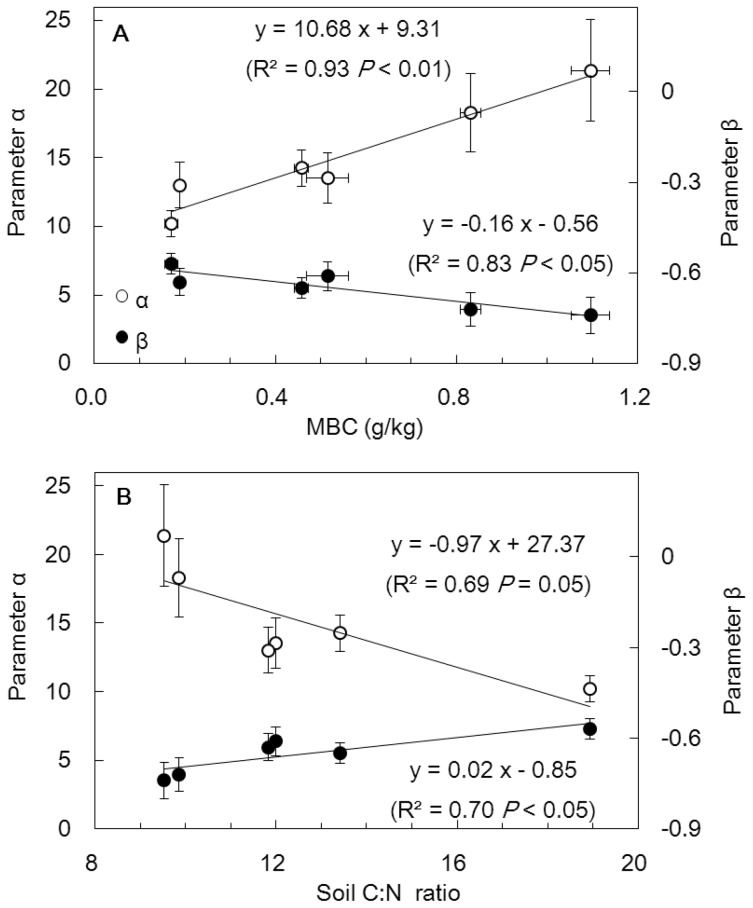
Dependence of parameters in the Q10−T curve on the soil microbial biomass carbon (A) and soil C: N ratio (B).Vertical bars denote the 95% CI of the estimated parameters in Fig. 3. For each parameter α and β, six points represent the three particles of clay, silt, and sand from the grassland and forest soils. Horizontal bars represent the standard errors (n = 4).